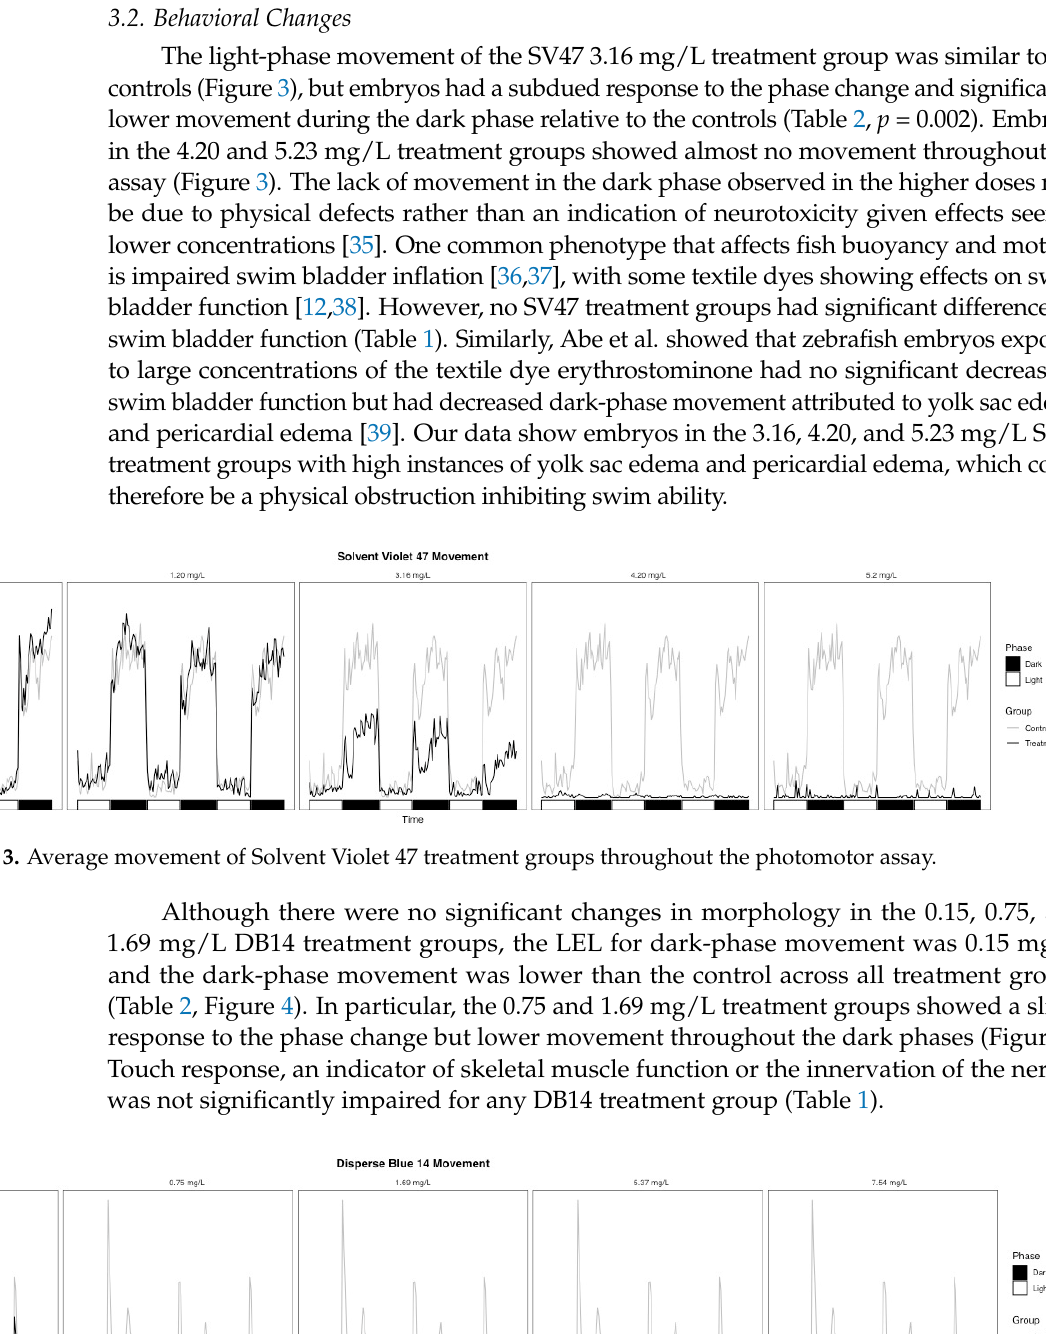
Table 2. Lowest Effect Levels (LEL) and Kolmogorov–Smirnov (P) p -values for movement. Delta = (Average Treatment Movement − Average Control Movement)/(Average Control Movement). Phase